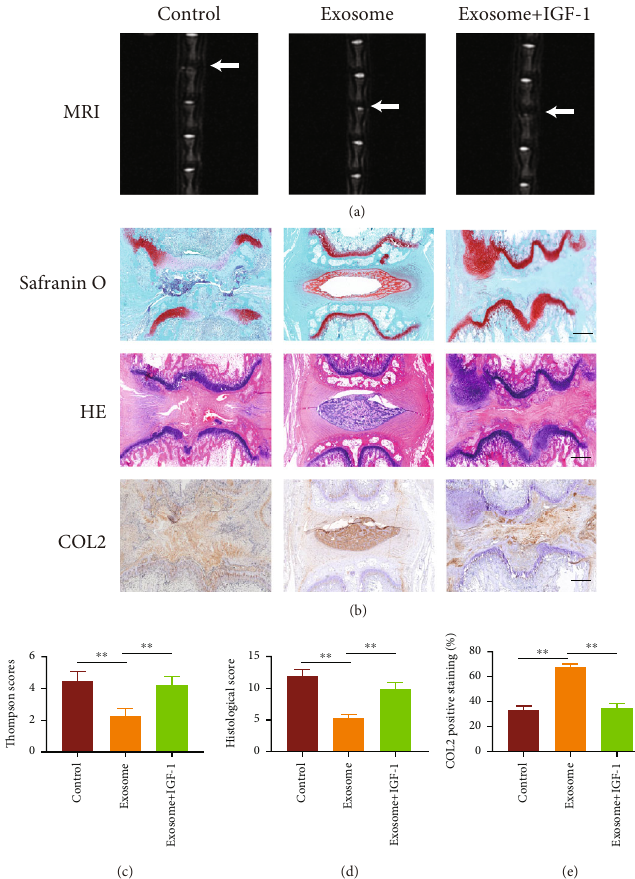
Figure 4: Results of the experiments in live animals. (a) MRI fi ndings after injection of exosomes and IGF-1 into the caudal disc of a rat. (b) Histological analysis of HE and S/O staining discs. Immunohistochemical staining of type II collagen showed the presence of type II collagen in the exosome group, but little in the control and exosome+IGF-1 groups. Scale bar: 100 μ m. (c) Thompson scores of three groups. The score of the exosome group is lower than that of the other groups. (d) Histological score showed signi fi cant imaging improvement at week 8 of the therapy with exosome, but higher in the control and exosome+IGF-1 groups; (e) Immunohistochemical staining of type II collagen area (%). ∗∗ P < 0 : 01